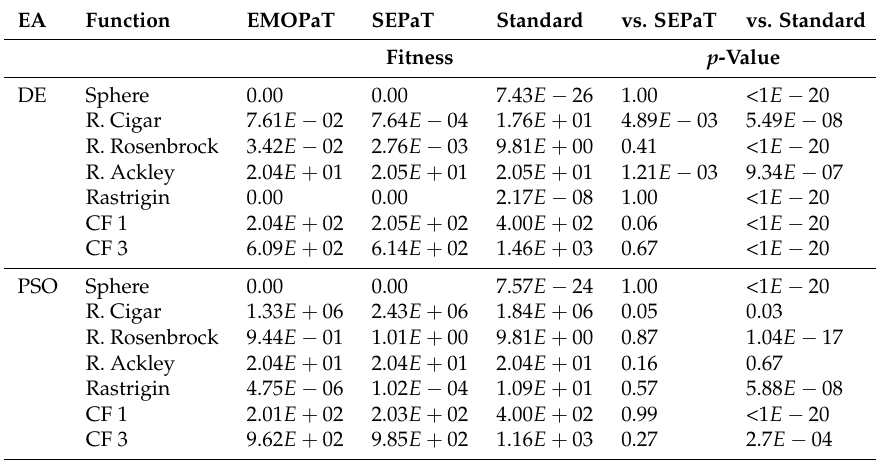
Table A3. Median fitness over 100 independent runs of the best solutions found by EMOPaT, by SEPaT, and by a standard configuration of the optimization